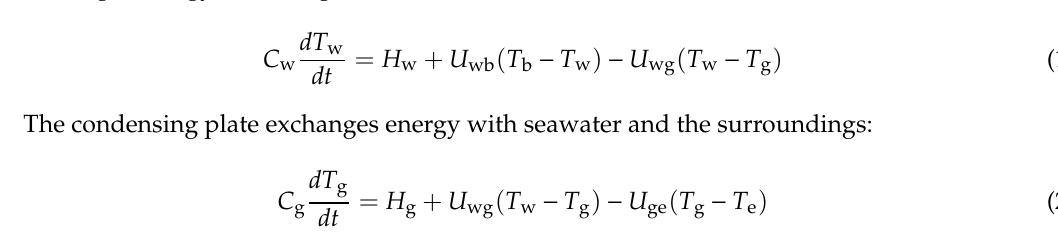
Figure 2. Heat ‐ transfer exchange mechanisms in a solar still.